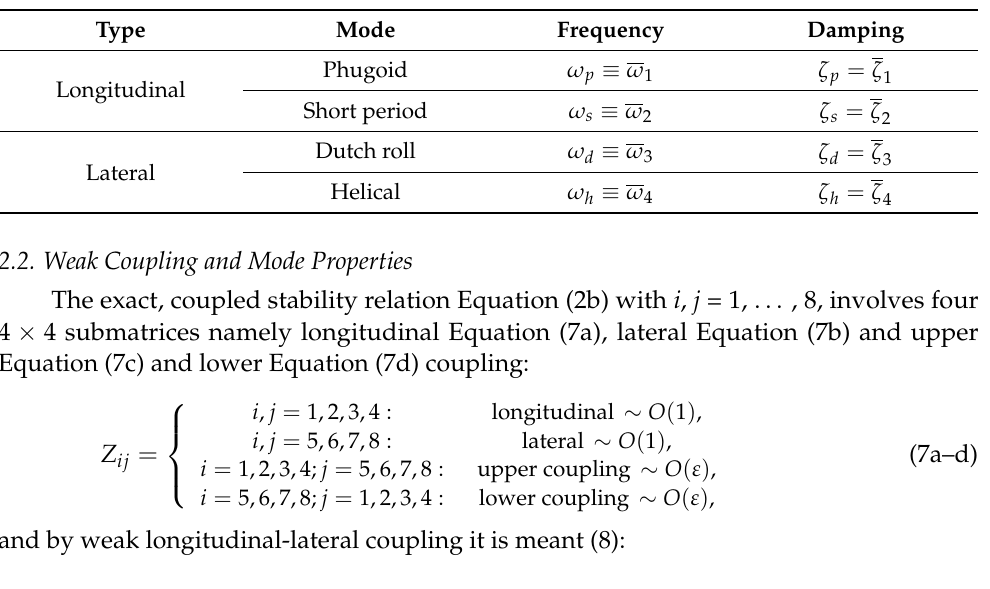
Table 1. Stability modes of a rigid